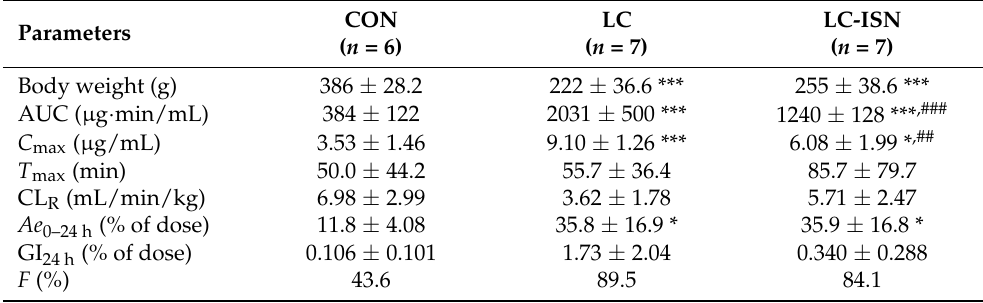
Table 3. Pharmacokinetic parameters of tofacitinib after oral administration at a dose of 20 mg/kg tofacitinib to CON, LC and LC-ISN rats. Data are shown as mean ± standard